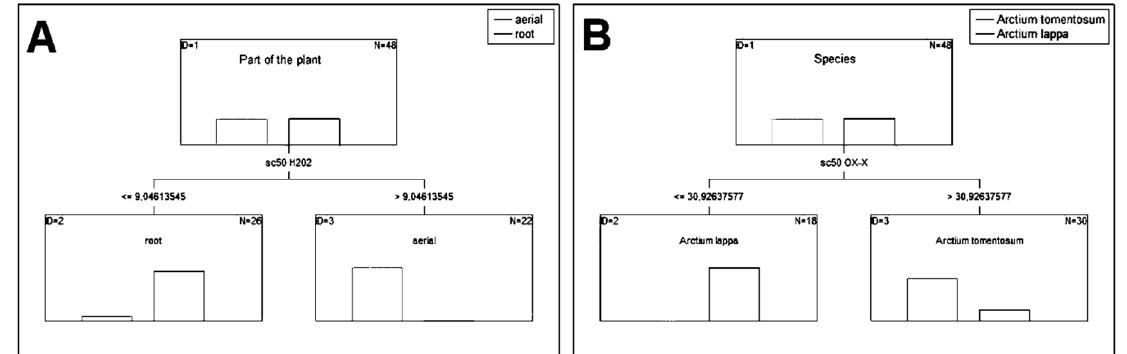
Figure 2. Classification and regression trees. ( A ): Classification and regression tree to distinguish plant parts based on SC 50 value for scavenging of hydrogen peroxide; ( B ): Classification and regression tree to distinguish species based on SC 50 value for scavenging of superoxide anion.